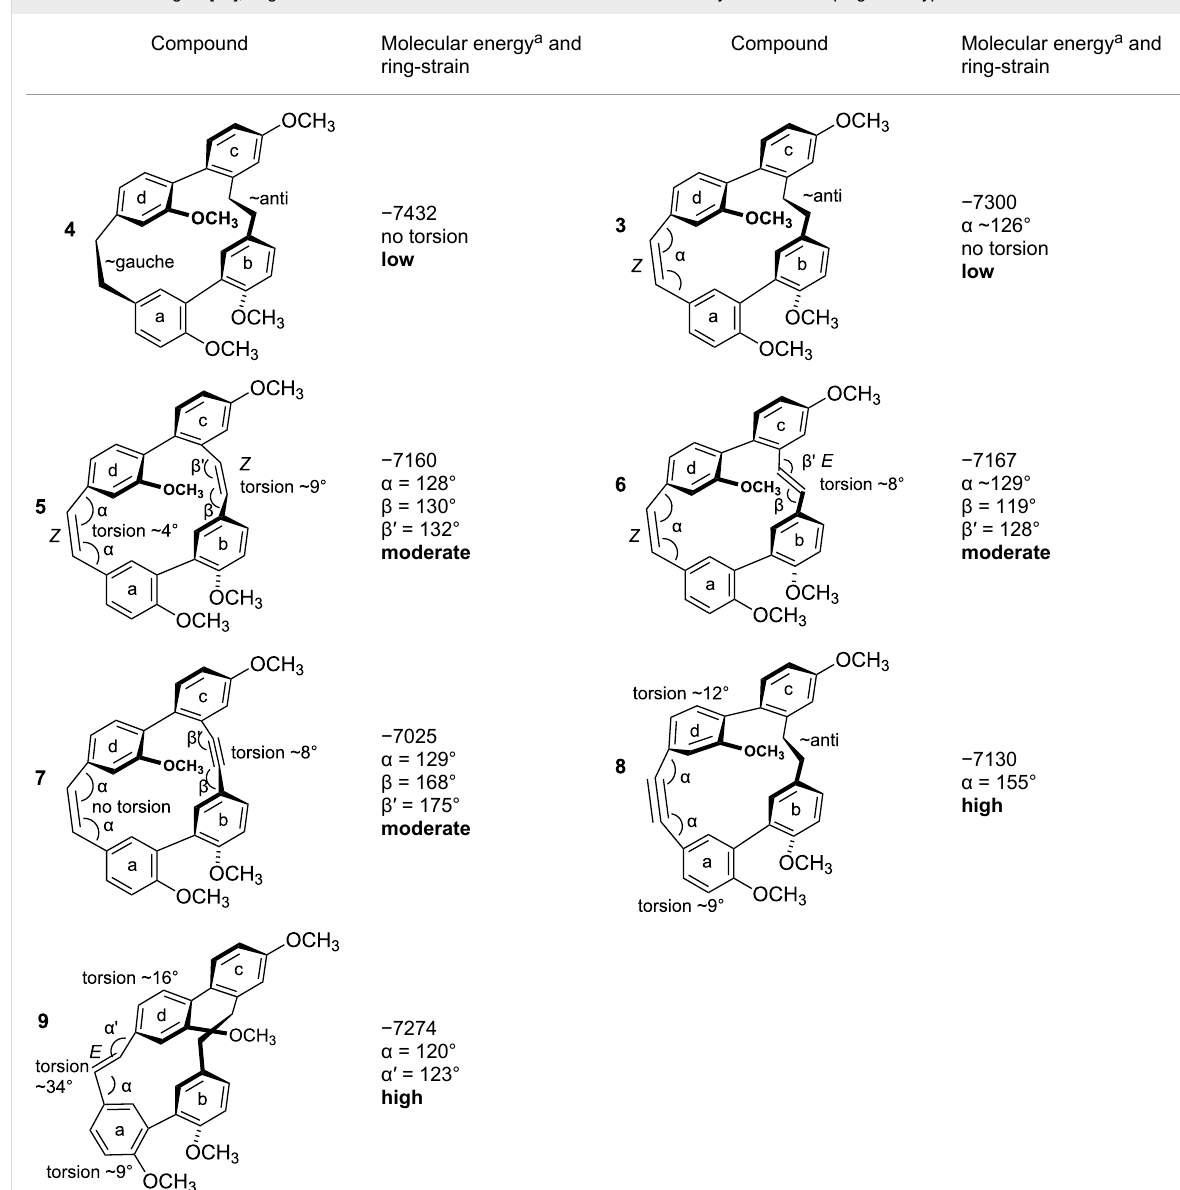
Table 1: AM1 energies [18], angular strain and torsion stress of different modified macrocycles of the isoplagiochin